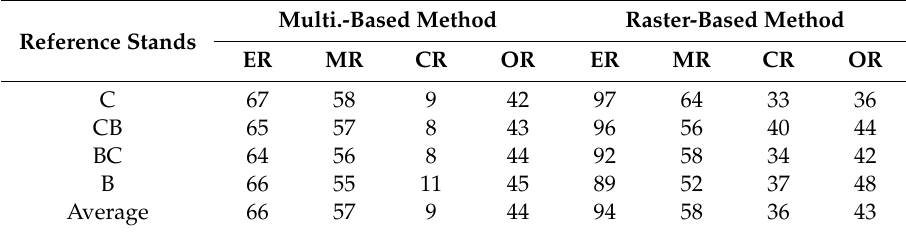
Table 3. Detection results of the multisource-based method and raster-based method. Reference